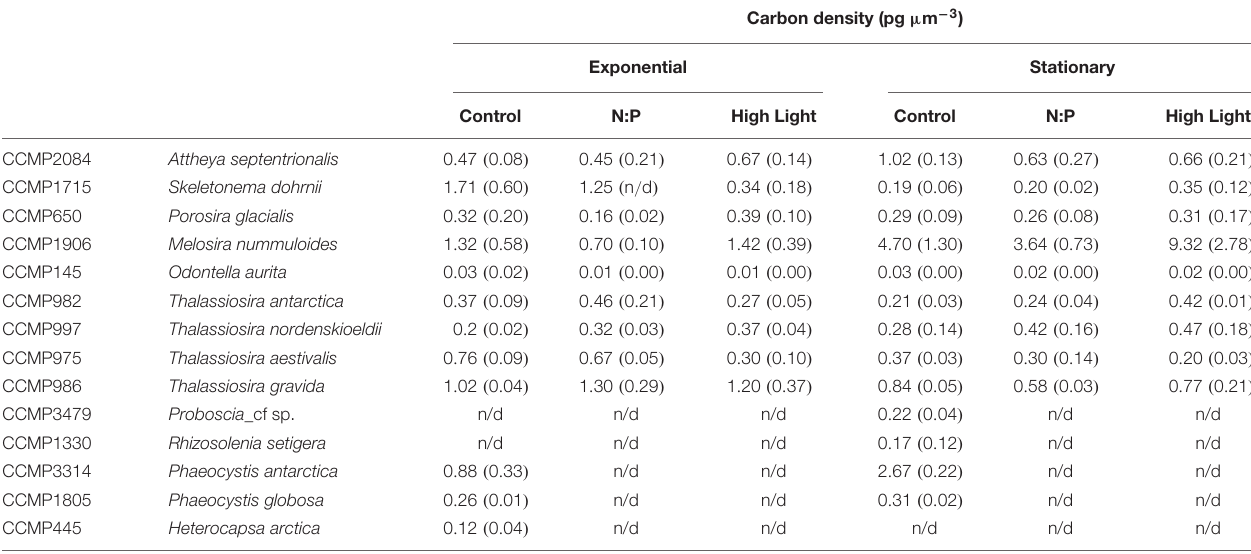
TABLE 3 | Comparison of carbon cell densities (pg C µ m − 3 ) for each of the strains used in this